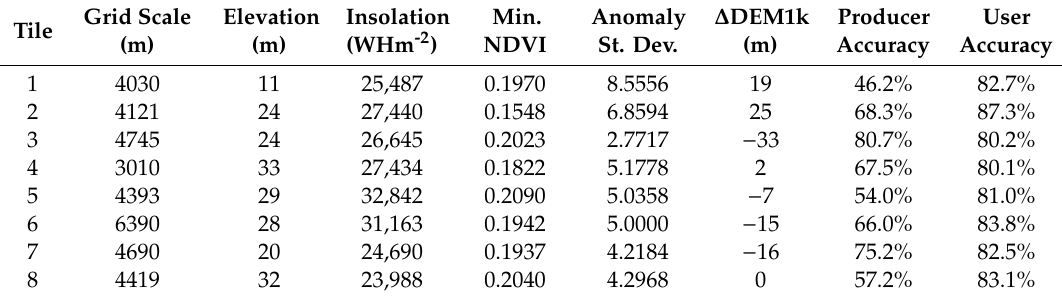
Table 4. Calibrated parameters for filtered NDVI data (values do not include 25% overlaps). Grid Tile